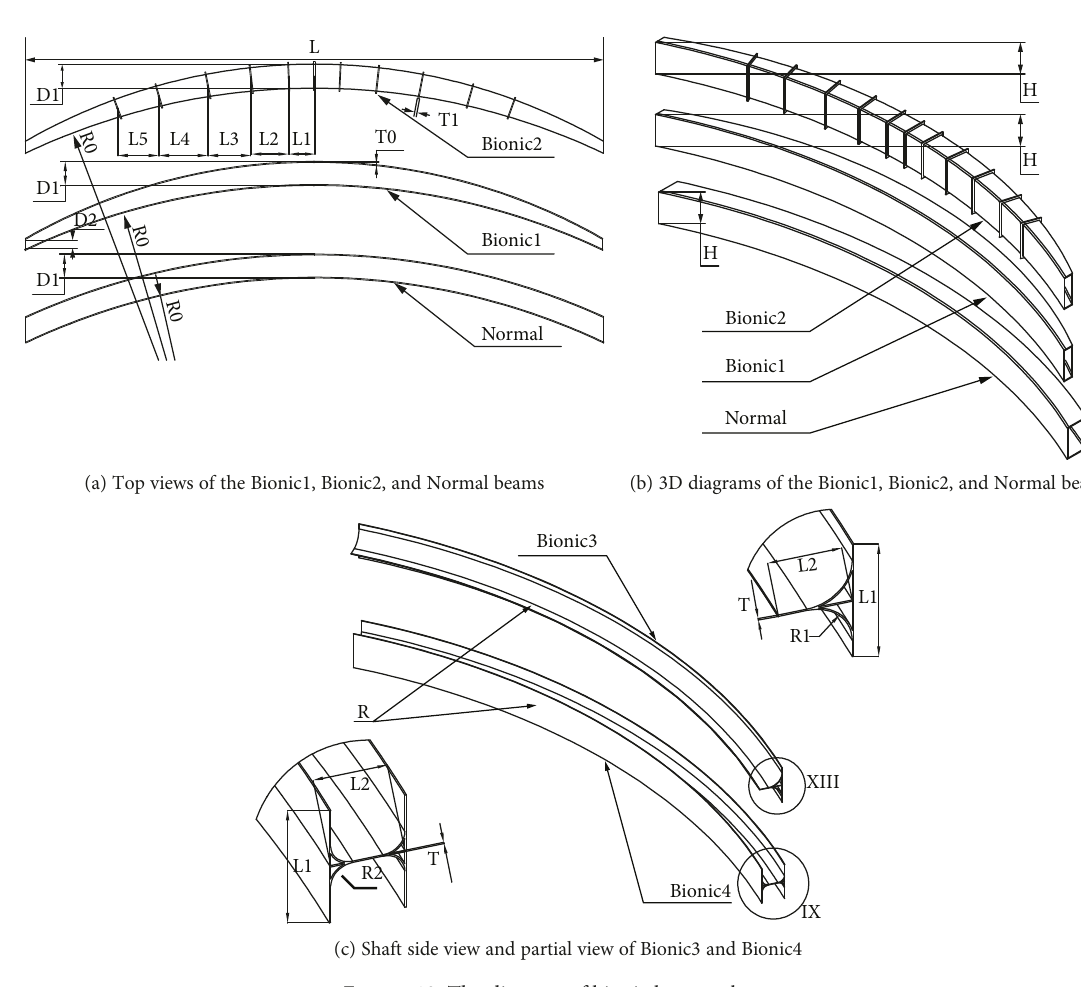
Figure 10: The diagram of bionic bumper beams. Table 2: Structure parameter of bionic bumpers